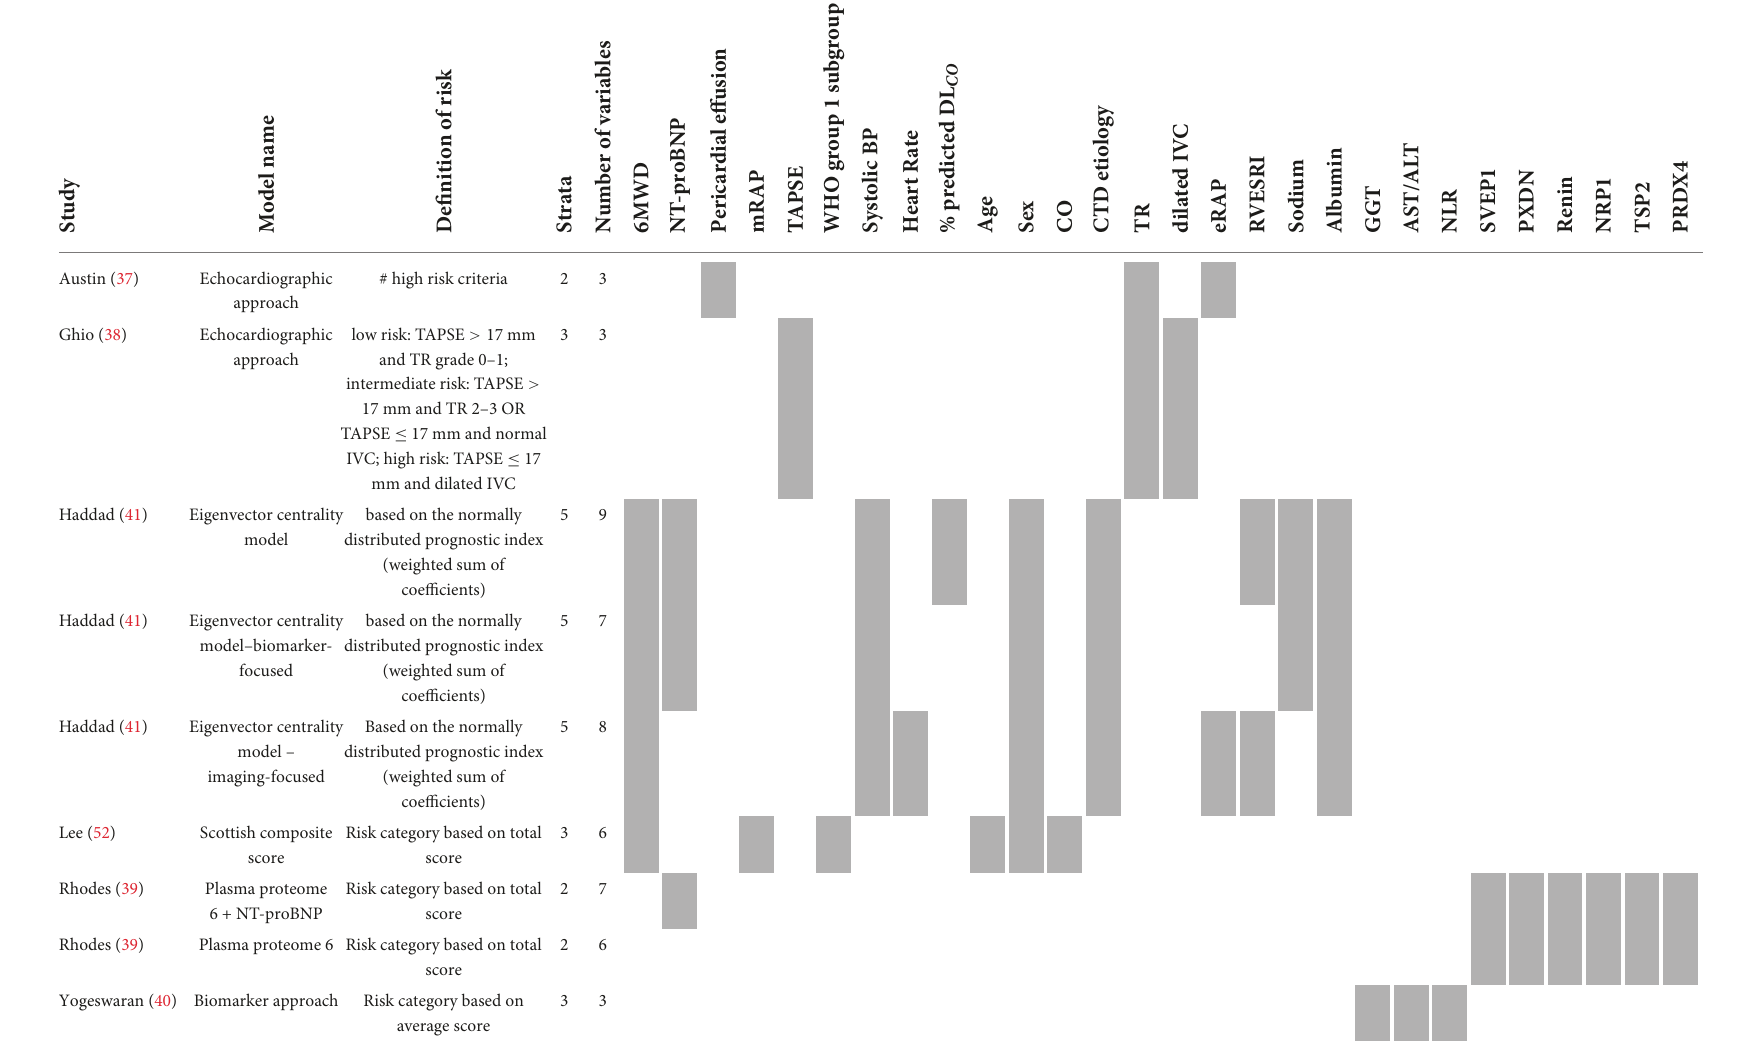
TABLE 6 Variables used in other risk stratification